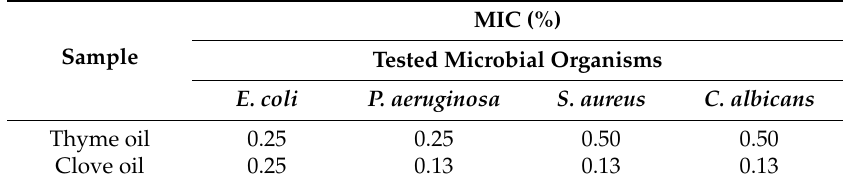
Table 2. The MICs of pure essential oils.